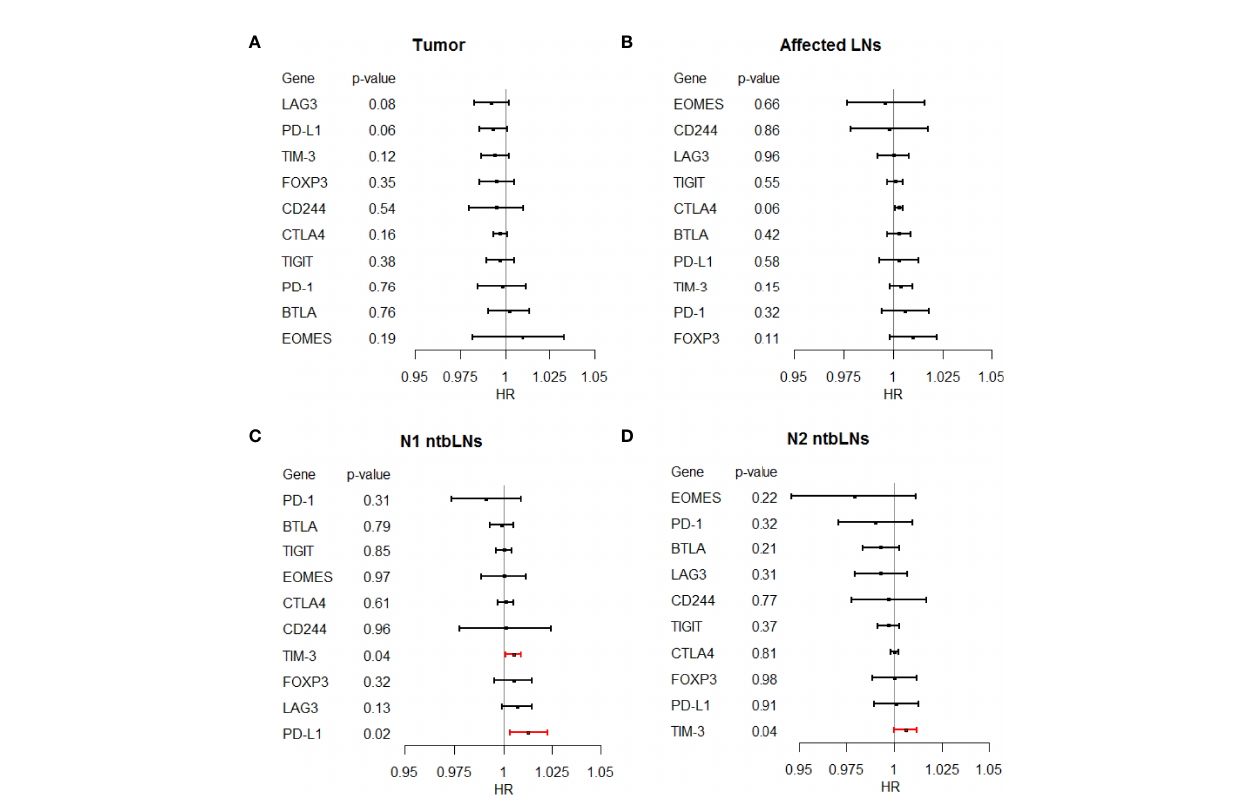
Figshare: https://doi.org/10.6084/m9. fi